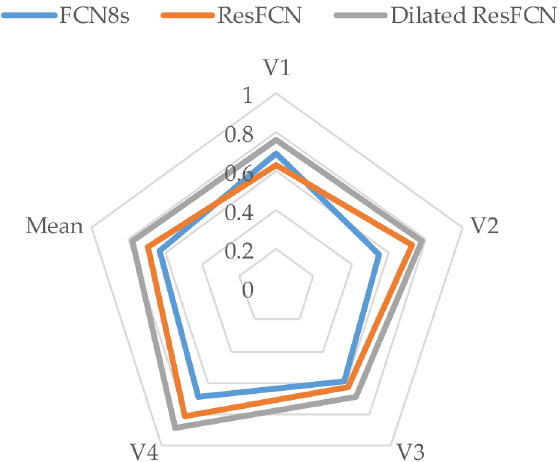
Figure 9. Graphical representation of Dice coefficient results for different segmentation methods overall and different validation subsets. The more outwardly located the contour, the better the results.